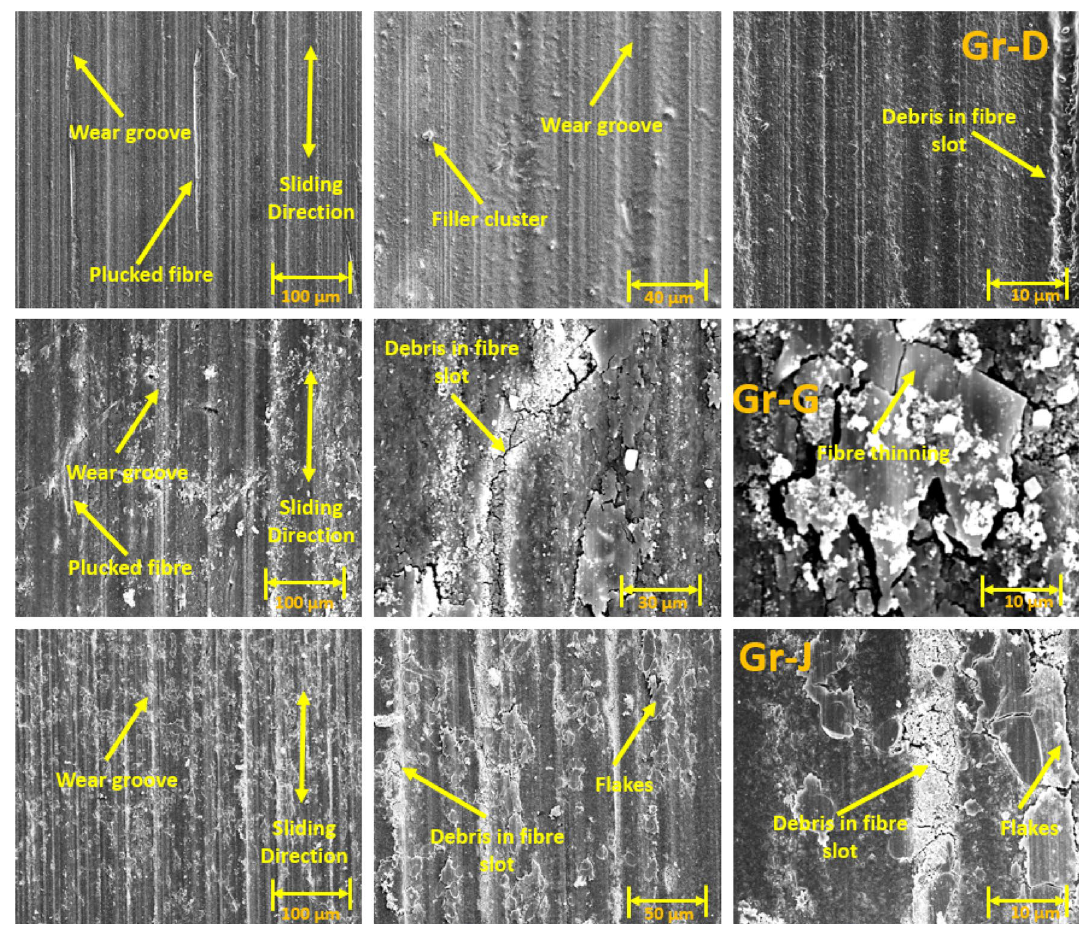
Figure 7. SEM images of 100 AR Group D (5 wt%), Group G (10 wt%) and Group J (15